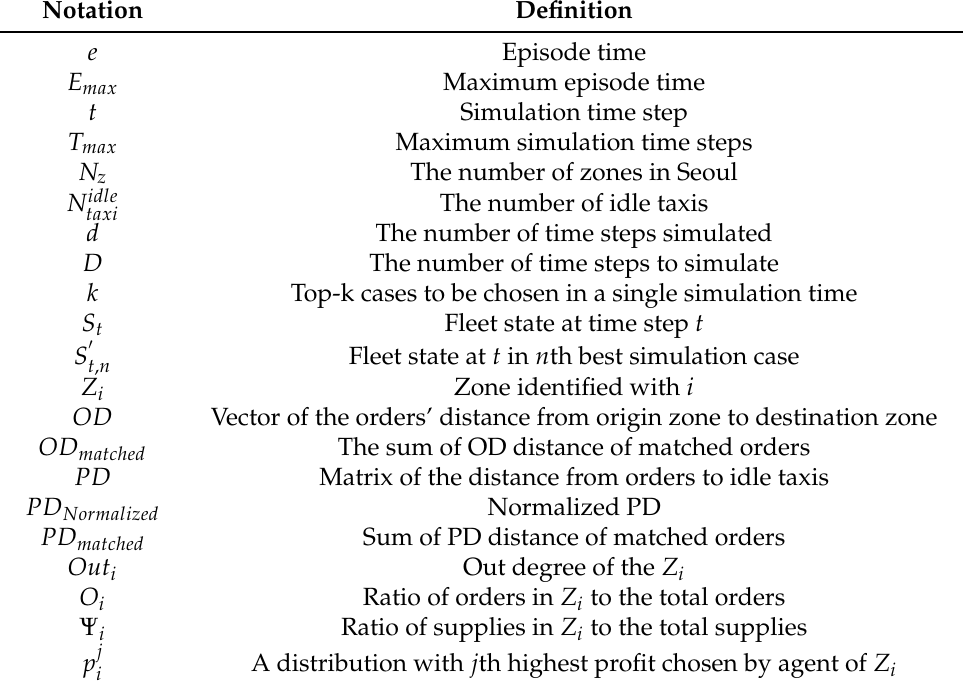
Table 1. Definition of the key notations used in this